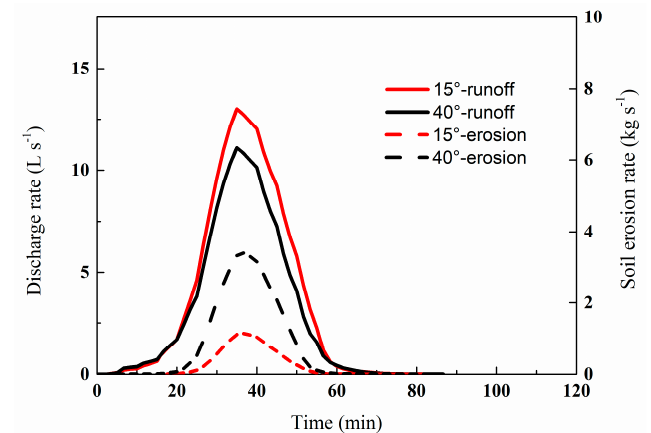
Figure 7. The comparison between the hydrographs and the sedigraphs under rising-falling rainfall at 25 m slope.